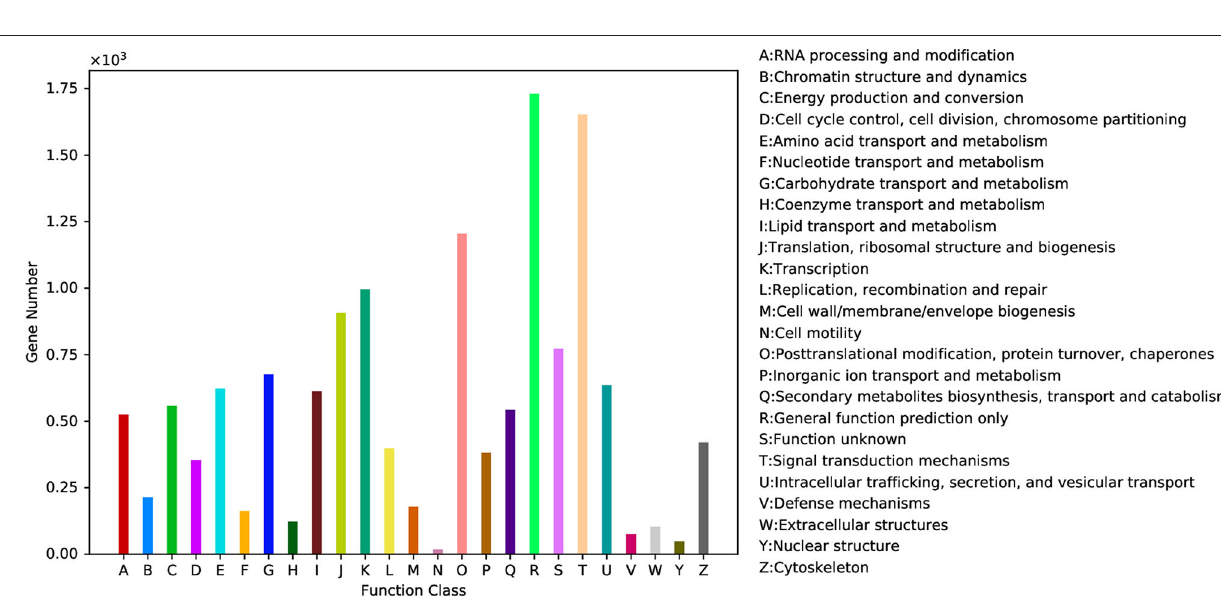
FIGURE 5 | Cluster of KOG classification of the